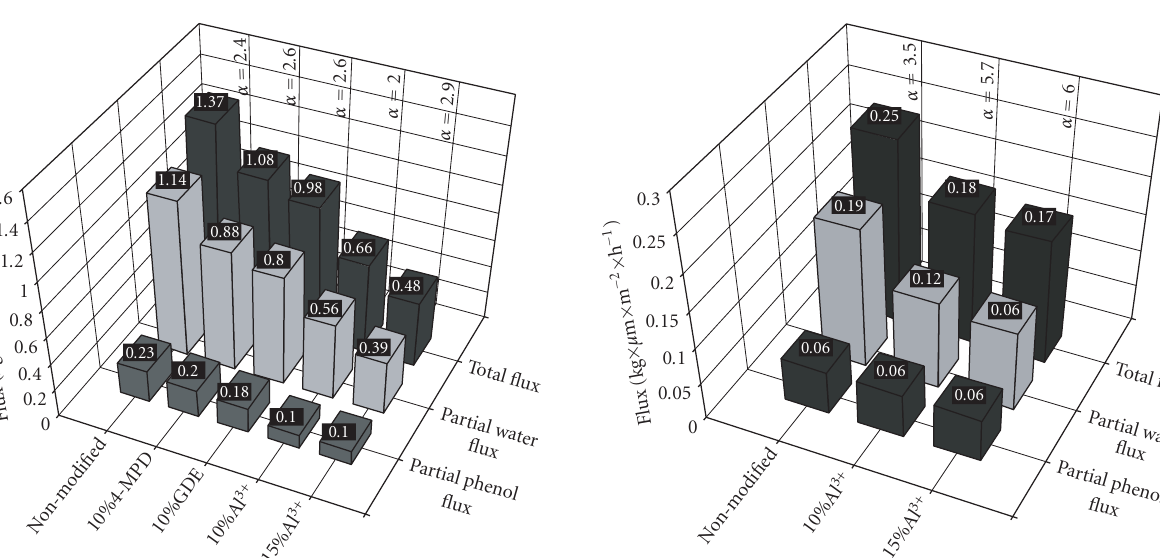
Figure 11: E-MAA 27 copolymer cross-linked ionically using 10% and 15% Al 3+ , feed concentration 8wt% phenol, membrane temperature